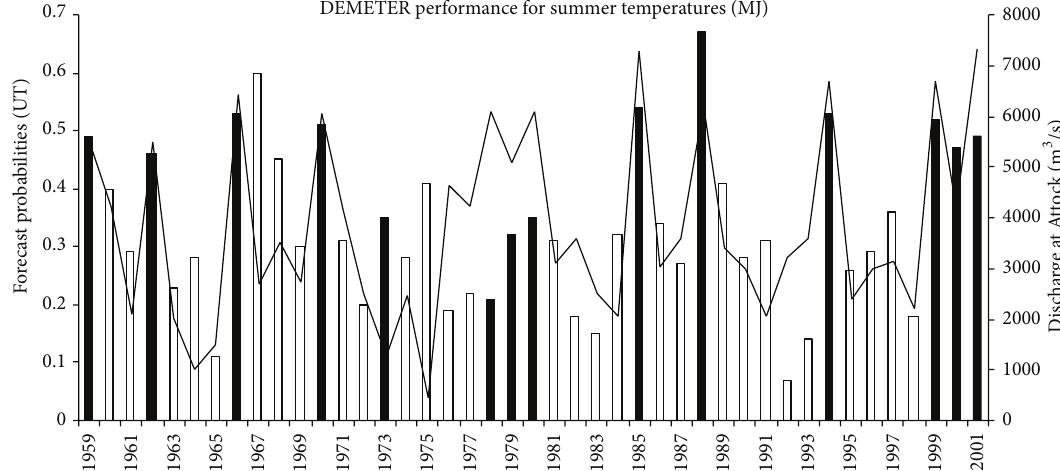
Figure 3: DEMETER forecast probabilities of upper tercile (UT) temperature obtained from February (4-5) forecast in northern Pakistan for the period of 1959–2001. Upper tercile years according to the observational data of PMD are shown with shaded bars and other years are shown with hollow bars. The line-plot indicates the average discharge data of May and June at Attock (River